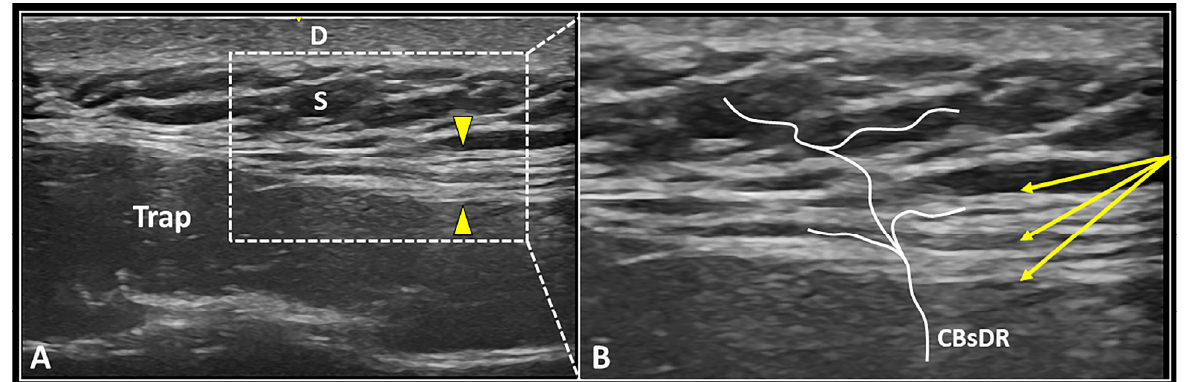
Figure 4. US image ( A ) shows the multi-layered deep fascia (yellow arrowheads) located between the upper fibers of the trapezius muscle (Trap) and the subcutaneous tissue (S). Under real-time US guidance ( B ), the needle (yellow arrows) can be advanced within the fascial structure, dissecting its different layers and releasing perforating cutaneous branches (CBsDR). D: dermis.